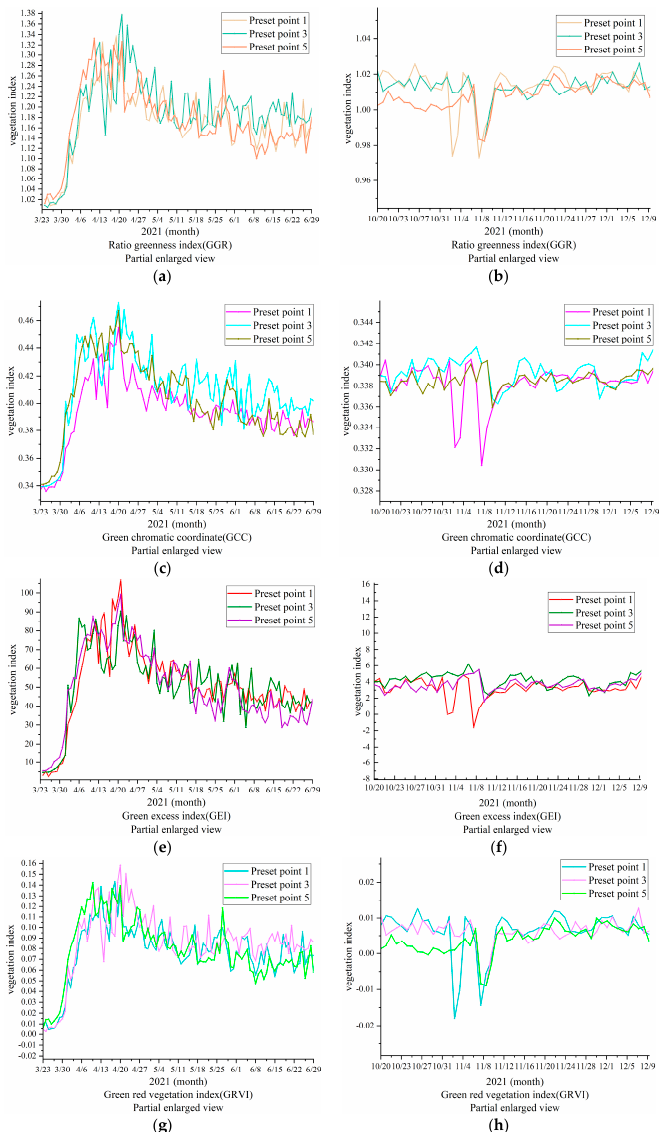
Figure 8. Partial enlargement of vegetation index: ( a ) GGR-local enlarged view during growth, ( b ) GGR-Detail enlarged view during defoliation, ( c ) GCC-local enlarged view during growth, ( d ) GCC-Detail enlarged view during defoliation, ( e ) GEI-local enlarged view during growth, ( f ) GEI-Detail enlarged view during defoliation, ( g ) GRVI-local enlarged view during growth, ( h ) GRVI- Detail enlarged view during defoliation.